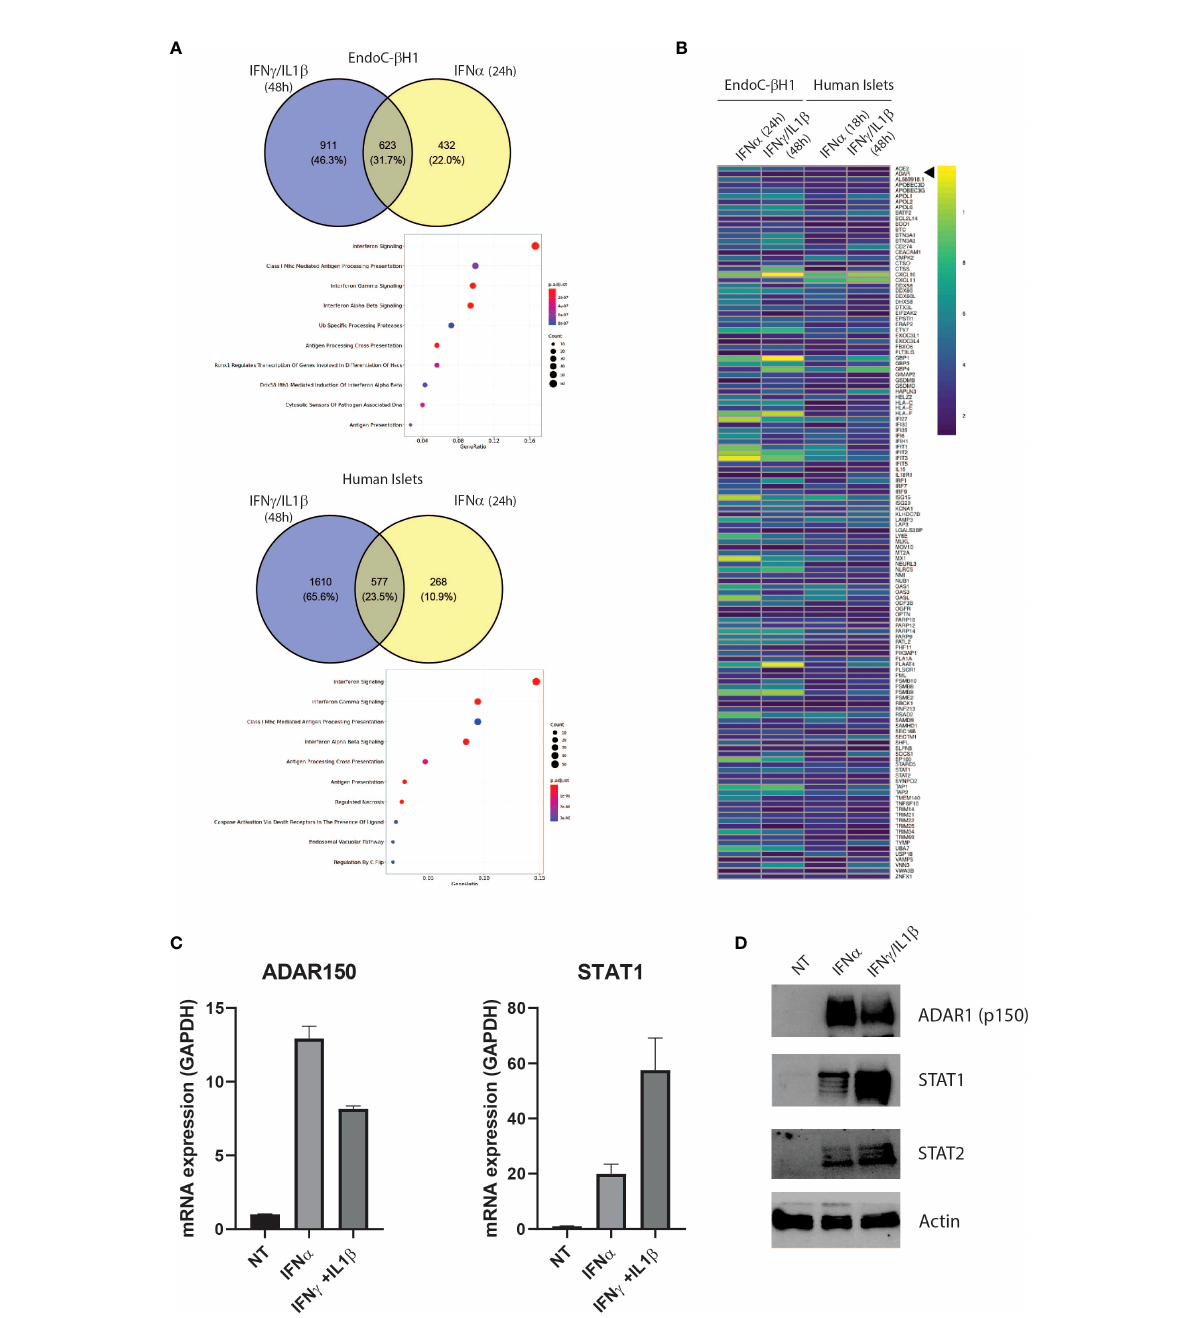
FIGURE 1 The proin fl ammatory cytokines IFN a and IFN ɣ +IL-1 b induce a partially shared gene signature in EndoC- b H1 and human islets Venn diagrams of up-regulated (log 2 FC > 0.58 and adj. P value < 0.05) genes in EndoC- b H1 and human islets after exposure to IFN ɣ +IL-1 b (A) , top) and IFN a (A) , bottom). Common genes have been tested for enrichment – using REACTOME as the reference – and signi fi cantly enriched pathways are represented as a dot plot: the x-axis represents the gene ratio and the y-axis the enriched pathways. (B) Heatmap representing the log 2 fold change of the 128 up-regulated genes in all 4 datasets (|log 2 FC| > 0.58 and adj. P value < 0.05). (C) ADAR1 p150 and STAT1 gene expression in EndoC- b H1 were assessed by qPCR after cytokine treatment. n=3 independent experiments (D) ADAR1 p150 ADAR1 (detected using Anti-ADAR1 #ab168809, Abcam), STAT1 and STAT2 protein expression determined by western blot. b -actin expression was used as loading